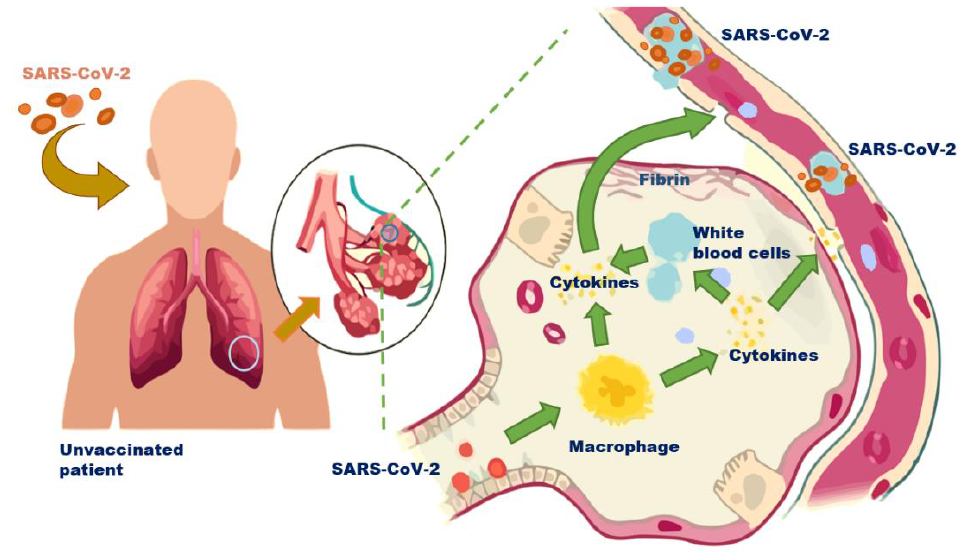
Figure 1. SARS-CoV-2 pathogenesis in an unvaccinated patient illustrating cytokine storm impact of damage to lungs and adjacent blood vessels.